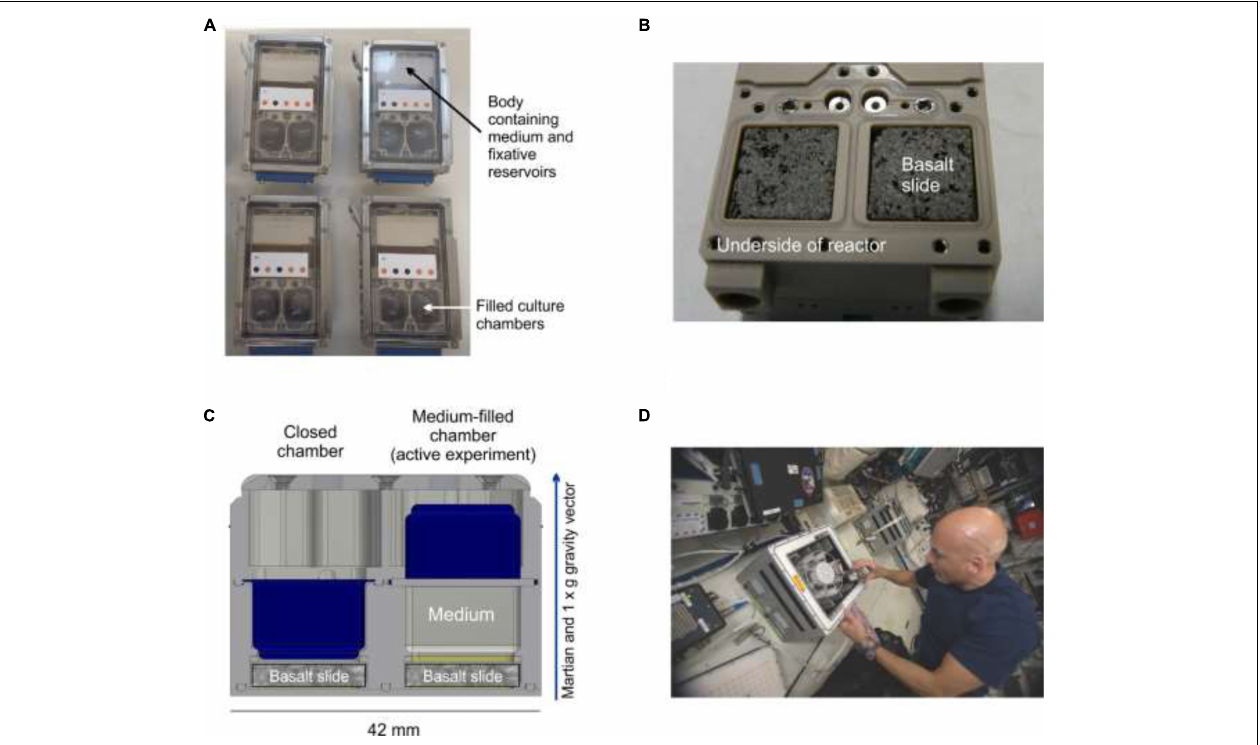
FIGURE 1 | The BioRock Experimental Unit (EU). (A) Top-down image of four Experimental Containers (EC) containing one EU each, showing medium inflated culture chambers. (B) Rear side image of the EU showing two basalt slides inserted into the bottom of the culture chambers before closure of EU. (C) A lateral cross-section through the culture chamber showing the position of the basalt slide at the back of the chamber and the principle of medium injection and inversion of the membrane (in blue; left side closed, right side inflated with medium). A scale bar shows the size of the unit, which also applies to the images in (A) and (B) . (D) ESA Astronaut Luca Parmitano inserts an EC into a KUBIK incubator on board the ISS (credit: